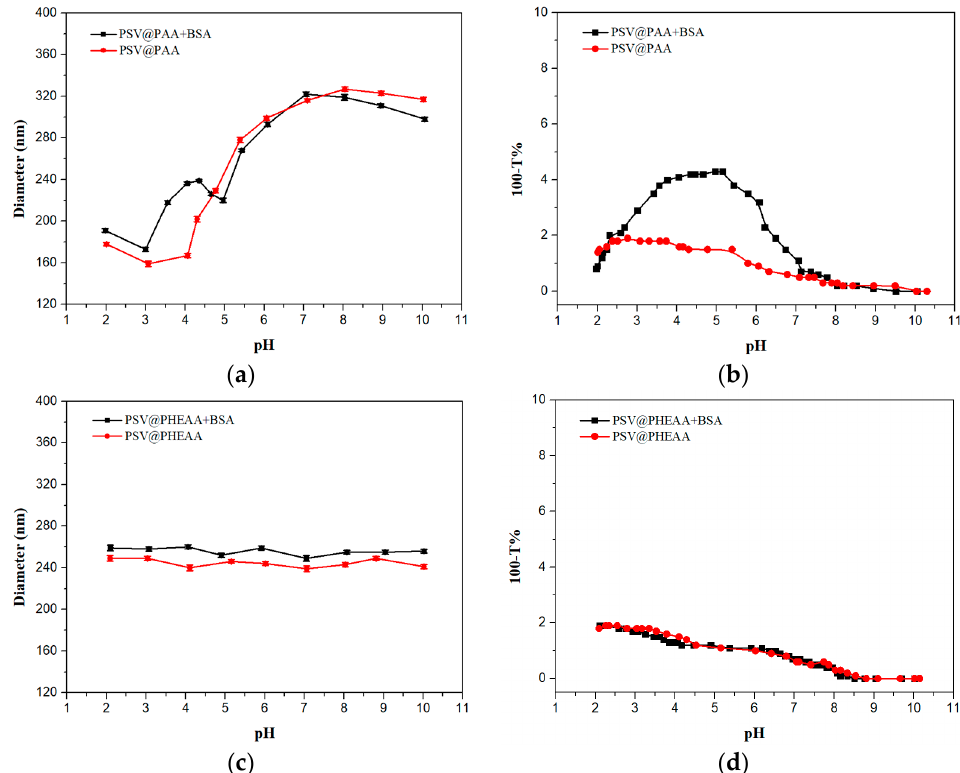
Figure 4. ( a ) Diameters and ( b ) turbidity of the mixture system of PSV@PAA with the BSA ( ) and BSA-free system ( ) and ( c ) diameters and ( d ) turbidity of the mixture system of PSV@PHEAA with the BSA ( ) and BSA-free system ( ) from pH 2 to pH 10.